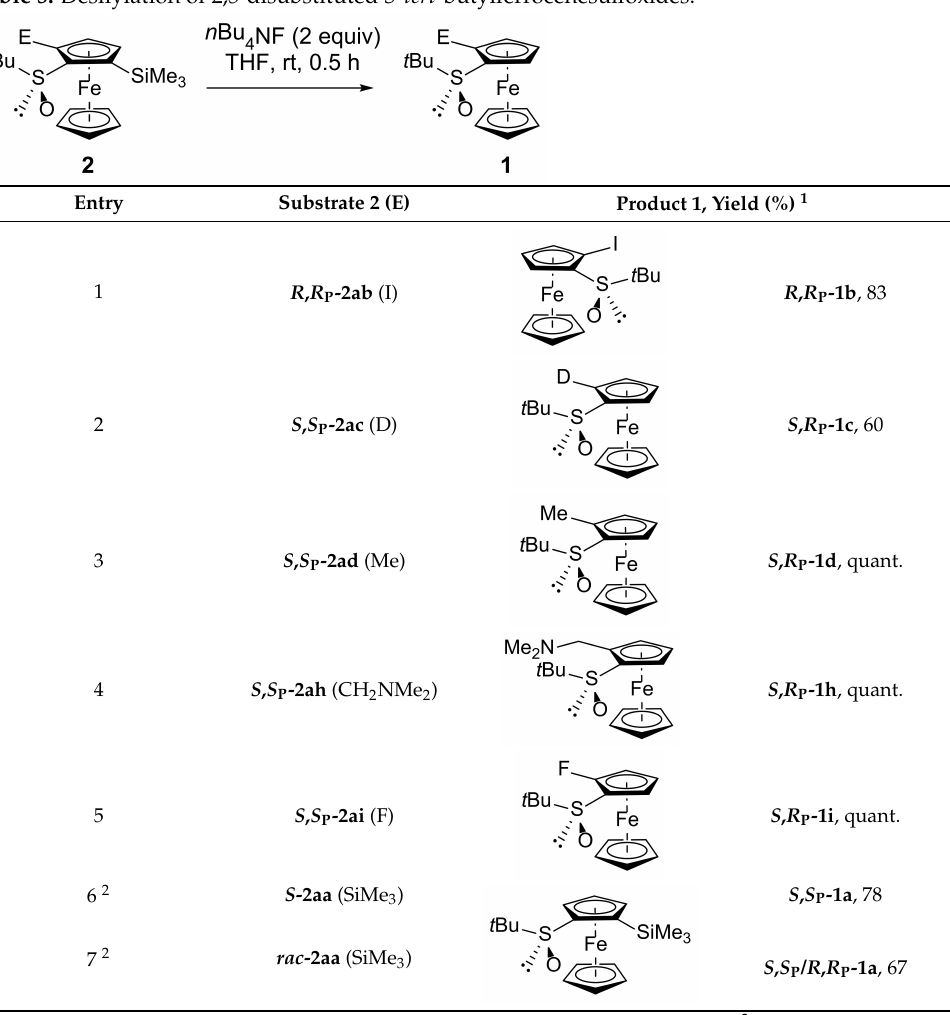
Table 5. Desilylation of 2,5-disubstituted S - tert